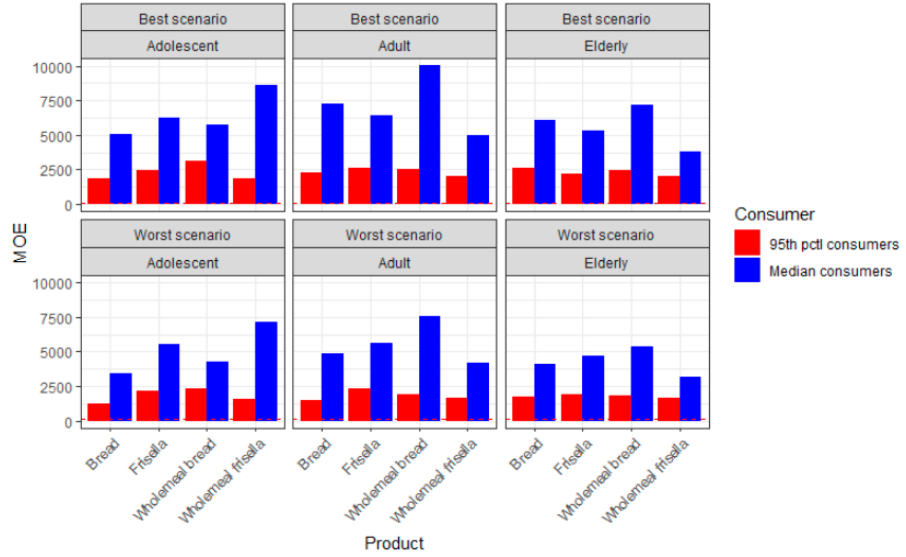
Figure 2. Margins of exposure (MOE) values for neurotoxicity of acrylamide (AA) through the consumption of bread and products thereof, across different consumers and according to best and worst scenarios (The y-intercept at 125 is a threshold, as it accounts for the minimum value at which the neurotoxic MOE is considered of low concern).